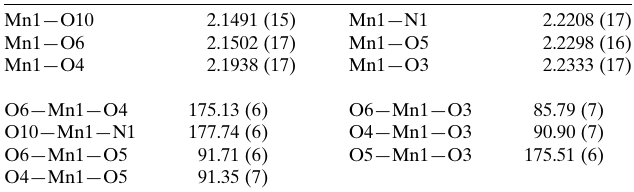
Table 1 Selected geometric parameters (A˚ , (cid:3) ) for (I).